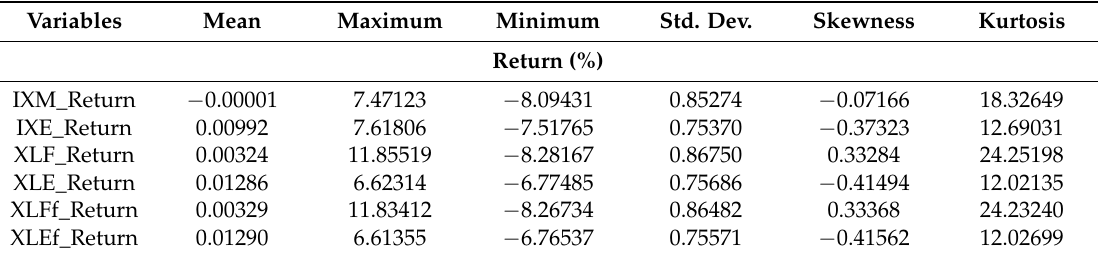
Table 2. Descriptive statistics (22 December 1998–22 April